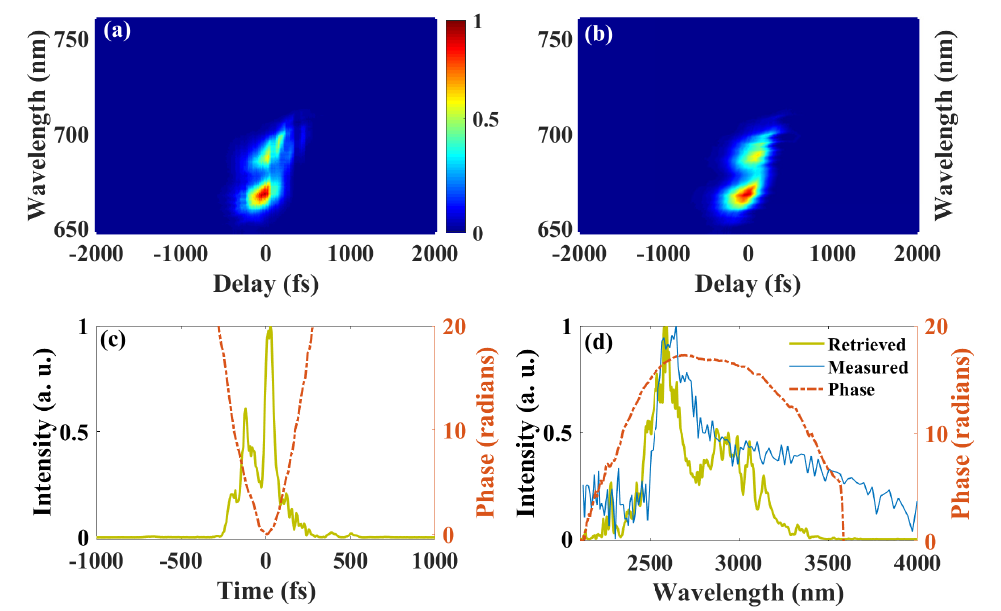
Figure 8. ( a ) Measured trace, ( b ) retrieved trace, ( c ) retrieved temporal profile, and ( d ) retrieved spectrum from the SFG-XFROG for SC pulses generated by the output of the regenerative amplifier after 30 round trips. Best error value of